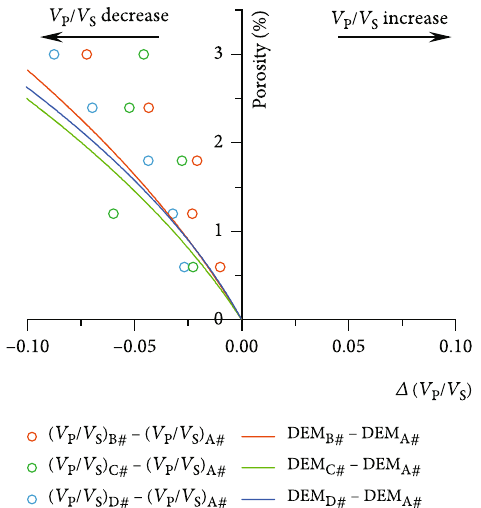
Figure 8: The variation in V